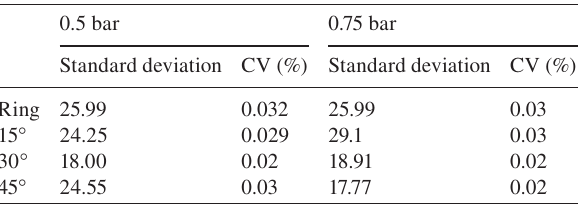
Table 5 Standard deviation and coeffi cient of variation values of twist test results.